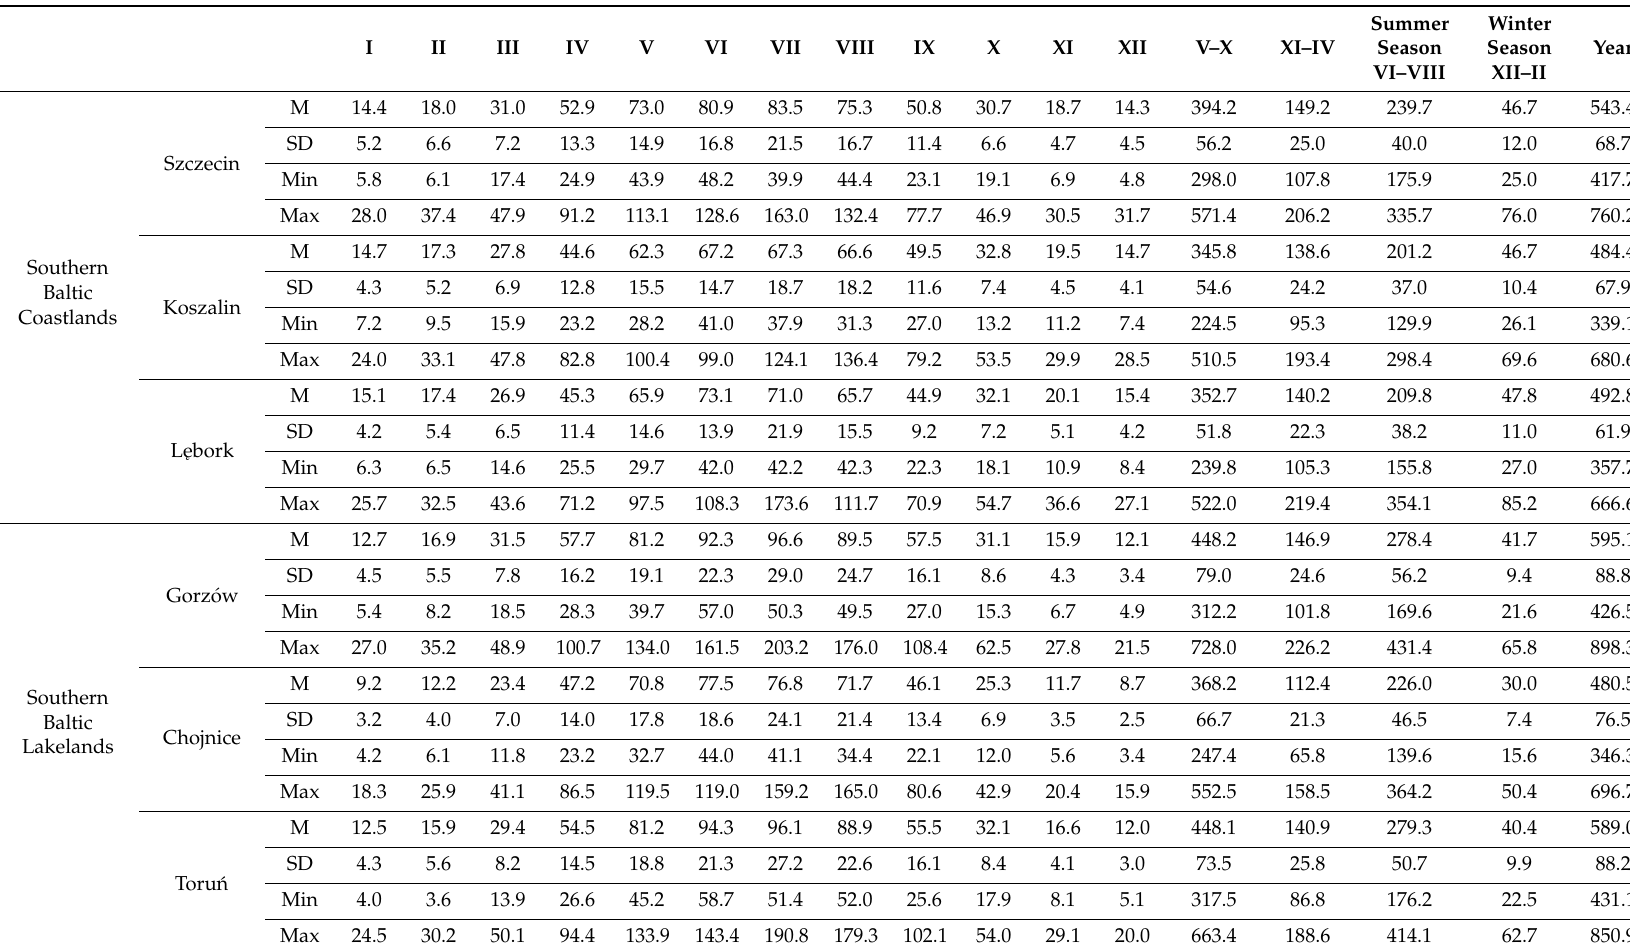
Table 6. Monthly, annual and semi-annual characteristics of sums of evaporation ( E 0 , mm) (1952–2018) (calculated based on t and f and data obtained from the Polish Institute of Meteorology and Water Management—National Research Institute